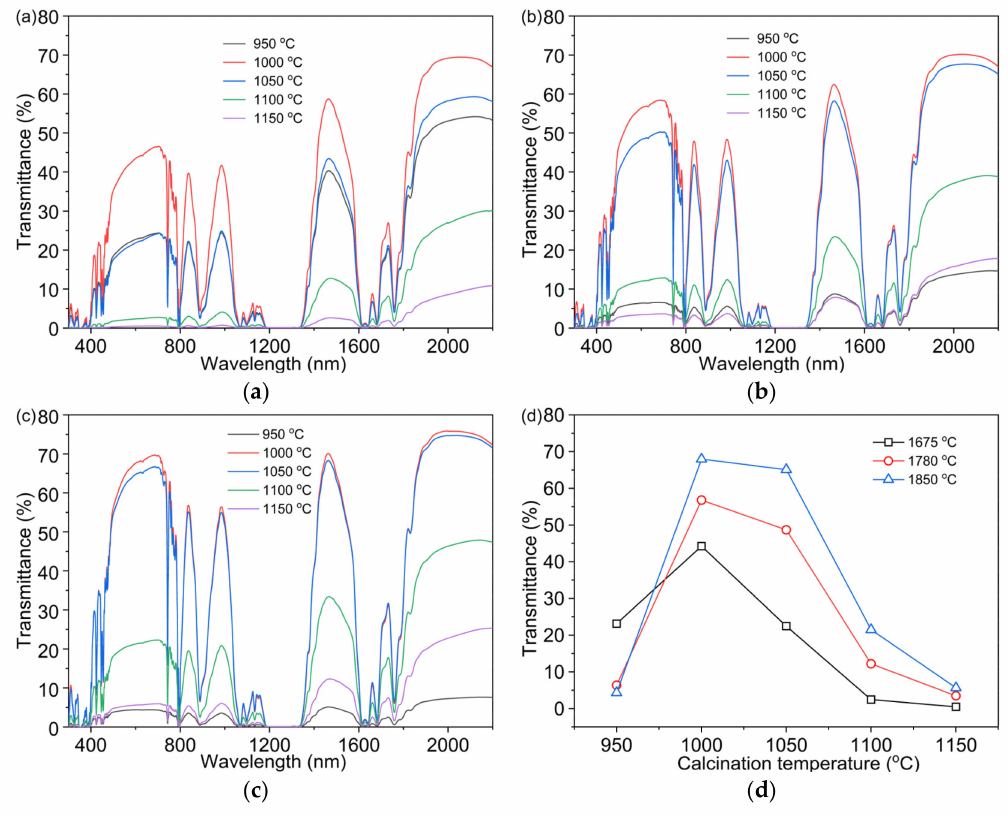
Figure 8. In-line transmittance curves of the Dy 2 O 3 ceramics sintered at 1675 ◦ C ( a ), 1780 ◦ C ( b ) and 1850 ◦ C ( c ) for 10 h followed by air annealing at 1400 ◦ C for 10 h using the powders calcined at 950–1150 ◦ C for 4 h and ( d ) the values of in-line transmittance at 633 nm versus calcination temperature for Dy 2 O 3 powders (thickness = 1.0